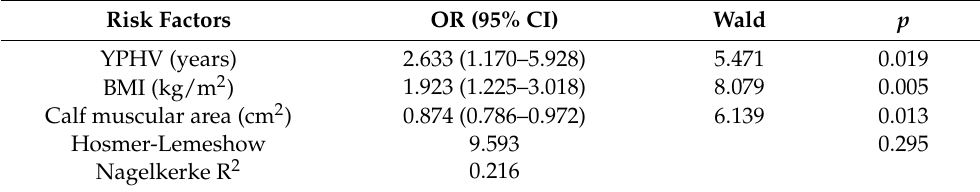
Table 4. Multivariate logistic regression analysis of potential injury risk factors in young soccer players. Risk Factors OR (95%